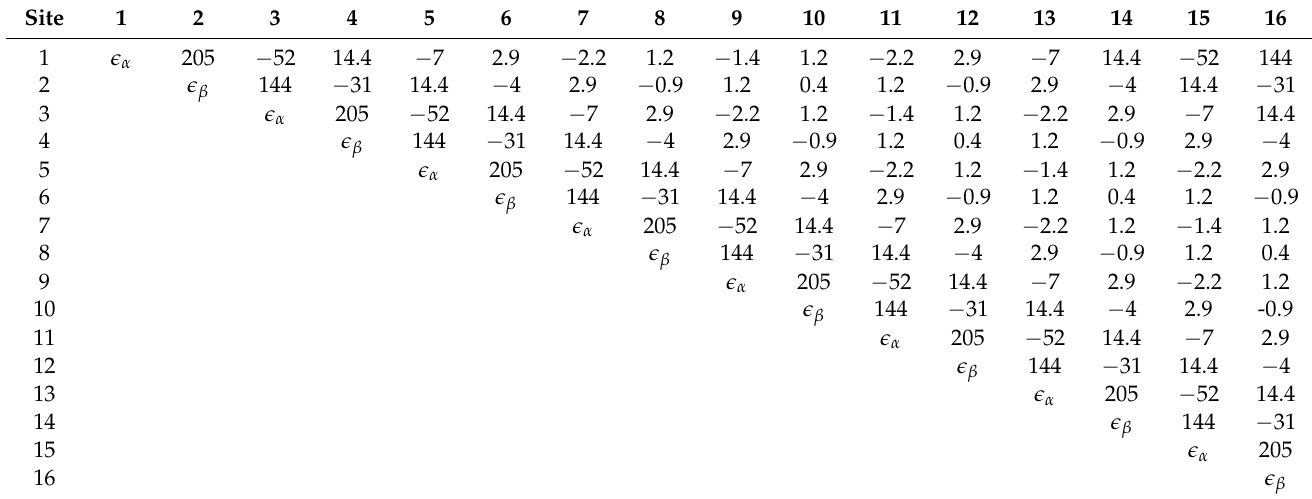
Table A1. Exciton Hamiltonian of a B850 ring (in unit of cm − 1